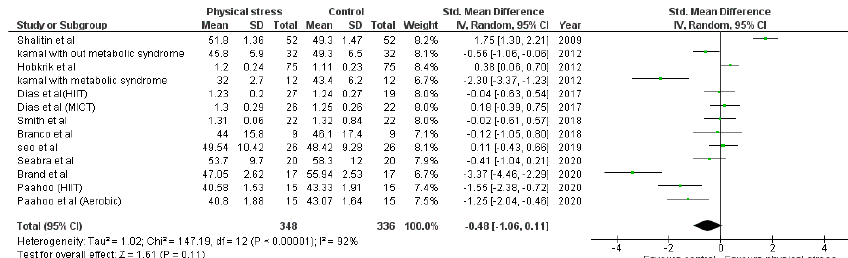
Figure 6. Forest plot showing the results for HDL.